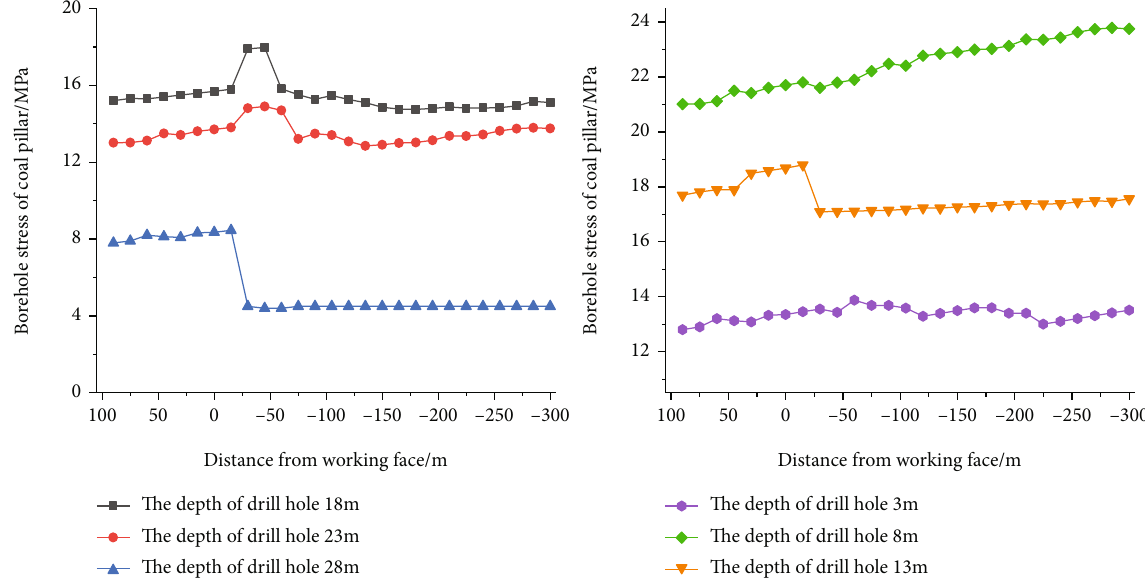
Figure 11: Relation between borehole stress of coal pillar and distance from working face.